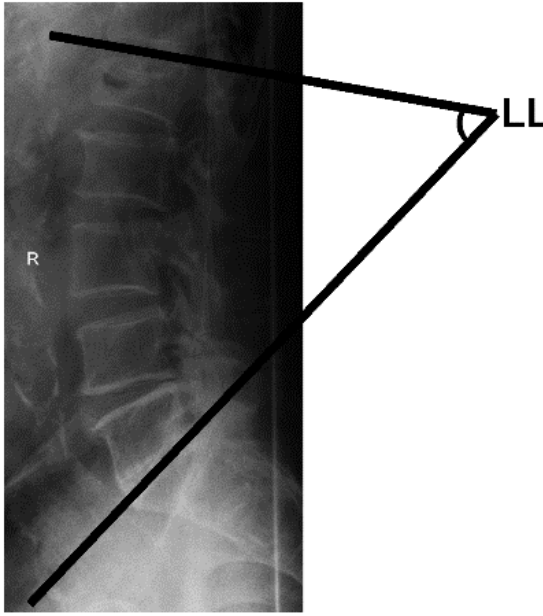
Figure 4. Total lumbar lordosis (LL) measurement.